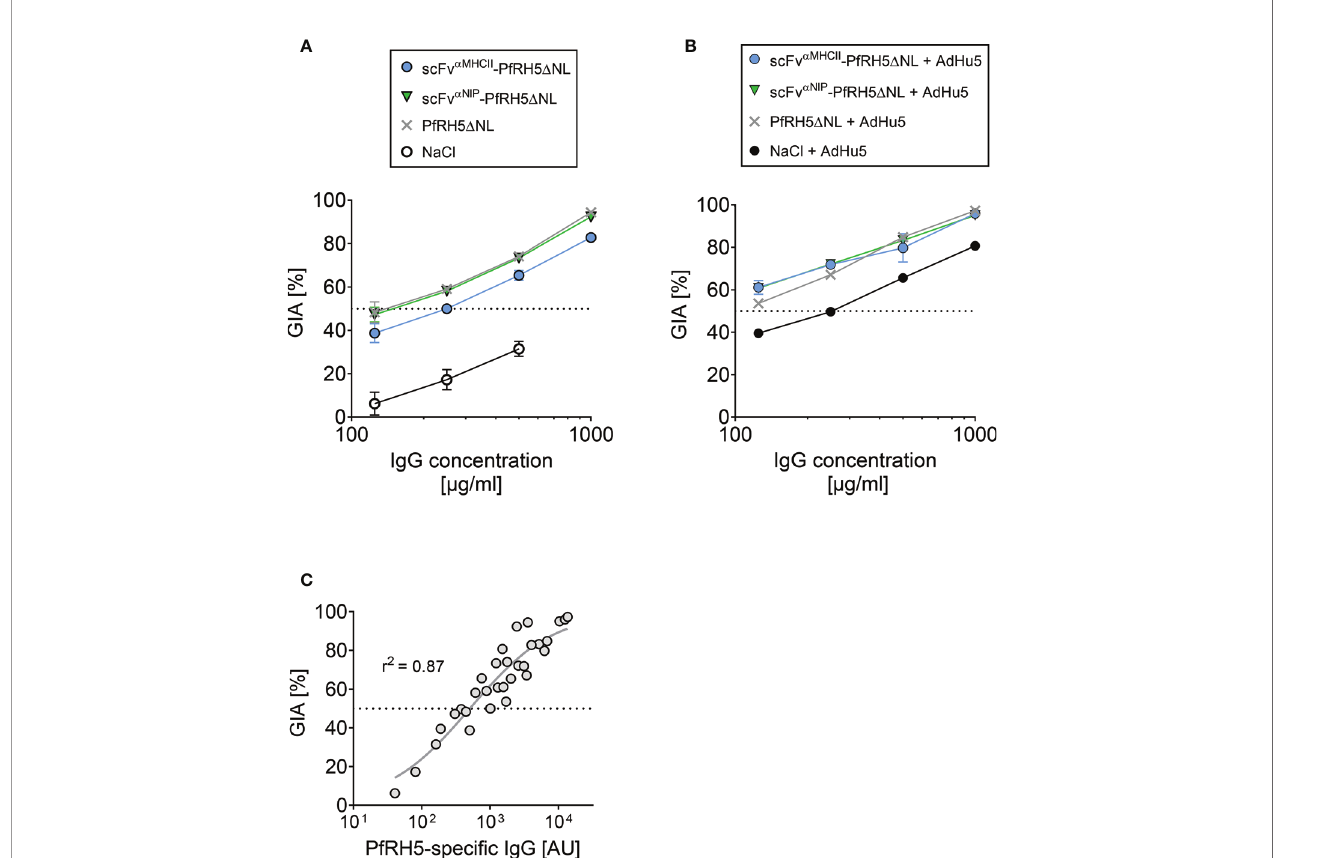
FIGURE 5 | Vaccine-induced antibodies showed in vitro growth inhibition activity against 3D7 clone P. falciparum parasites. (A, B) In vitro growth inhibition activity (GIA) of puri fi ed IgG was assessed against 3D7 clone P. falciparum parasites. Dilution series of puri fi ed IgG from mice vaccinated i.m./EP three times (at day 0, 21, and 42) with indicated DNA plasmids or NaCl (A) , and from mice with an additional PfRH5FL-adenoviral boost at day 63 (i.m., 1x1010 IU/mouse) (B) . Sera were harvested at day 77 post-prime vaccination. The GIA assay was performed on pooled sera from n = 5 mice/group. (C) Relationship between GIA (%) for the dilutions shown in (A) and PfRH5FL-speci fi c IgG titers as measured by ELISA in the puri fi ed IgG test samples. 50% GIA is marked (stippled line). Non-linear regression curve is shown (grey line, r2 = 0.87, n =